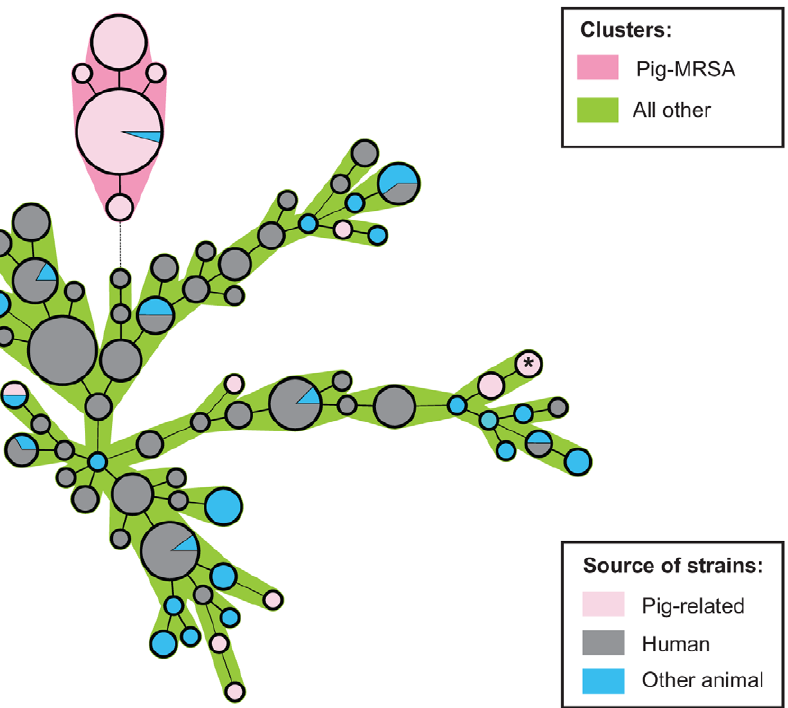
Figure 3. Minimal spanning tree of S.aureus isolates of human and animal origin. Nodes represent binary IS types. Node colour corresponds to the source of the strains, pig farming-associated, human or other animal. Node size corresponds to the number of strains of identical IS type within that node. When isolates of different sources have identical profiles, the node is depicted as a pie chart, the size of individual parts indicating relative abundance of different sources in that node. The pig farming-associated MRSA isolates (in pink) clearly form a distinct cluster. Only one of the pig farming-associated MRSA isolates (with ST 9) fell outside of this cluster and instead clustered with MSSA isolates obtained from pigs. This strain is marked with an asterisk (*) in the figure. Besides the pig farming-associated MRSA isolates, not many IS types are found in both humans and animals. Within the central node of the pig farming-associated MRSA cluster, one isolate derived from another animal can be found. This is the MSSA isolated from a monkey.